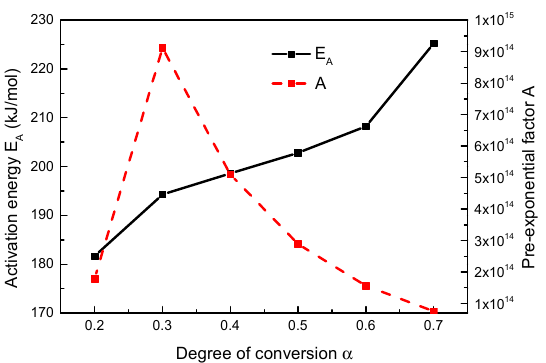
Figure 8. Activation energy and pre-exponential factor as function of fractional mass loss by Ozawa method under inert atmosphere.